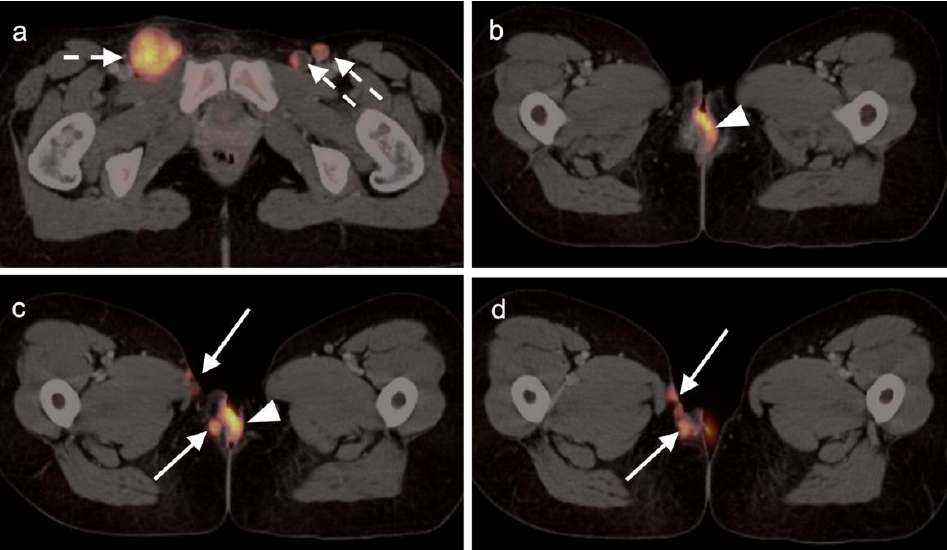
Figure 20. Vulvar squamous cell carcinoma on axial FDG PET-CT images of the pelvis. ( a ) Axial FDG PET-CT demonstrates bilateral inguinal lymph node involvement (white dashed arrows); ( b , c ) the vulvar carcinoma is markedly hypermetabolic on FDG PET-CT (white arrowhead); ( c , d ) there is spread of the vulvar carcinoma into the adjacent subcutaneous tissue on the right, as well as the skin of the right medial thigh (white arrows).